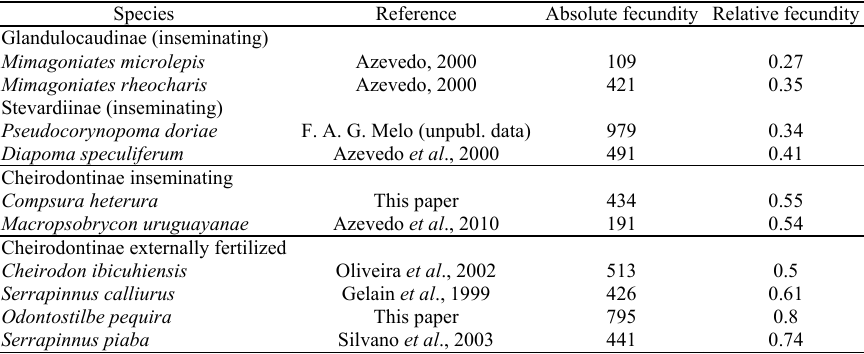
Table 3. Comparative data of absolute fecundity and relative fecundity of glandulocaudine, stevardiine, inseminating cheirodontine and externally fertilized